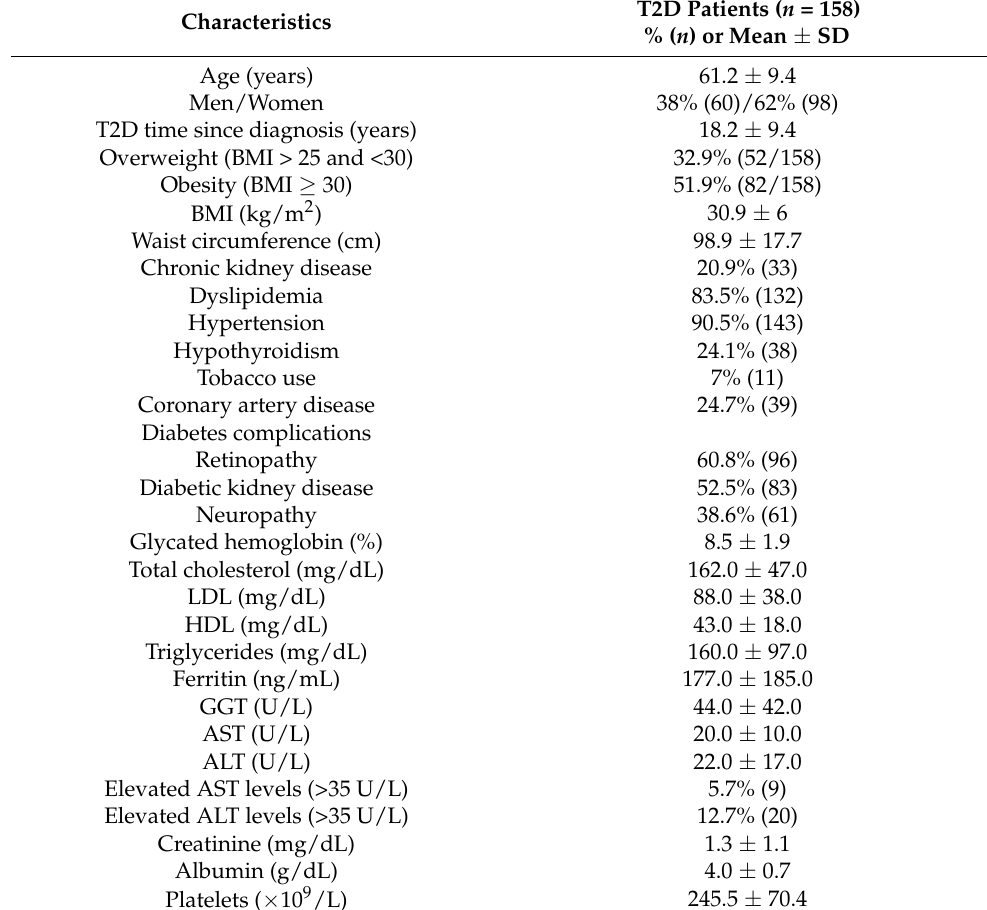
Table 1. Demographic, clinical, and biochemical characteristics of the included patients ( n =